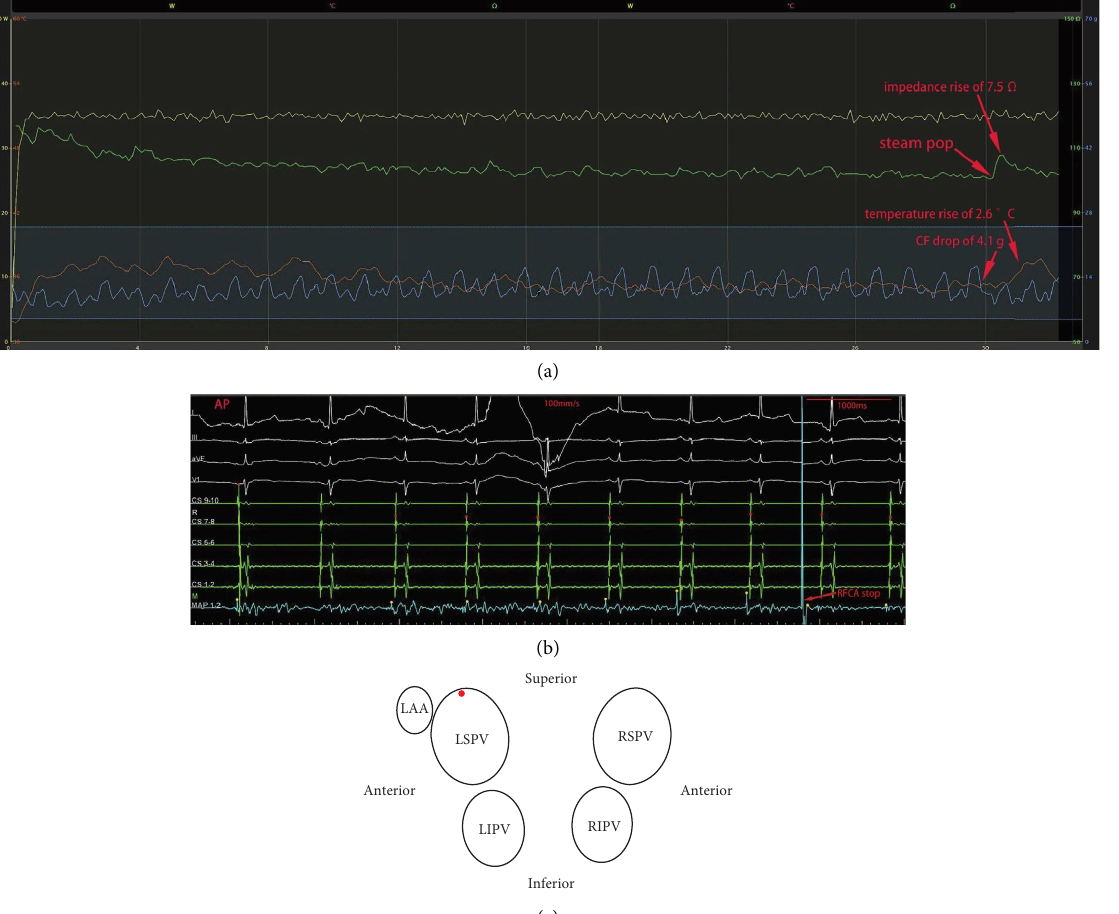
Figure 2: (a) RFCA graph showing the course of the parameters during RFCA. Te time from the initiation of RFCA to the occurrence of audible SP was 30.2 s. Te occurrence of a SP was associated with a preceding impedance drop of 17.6 Ω . Te sudden impedance rise after 30.2s of RFCA coincided with a SP. Immediately after the SP, an abrupt impedance rise of 7.5 Ω , temperature rise of 2.6 ° C, and CF drop of 4.1g were recorded. (b) A spike potential was not recorded immediately during the occurrence of SP. (c) Te location of the SP is at the anterior-superior wall of the